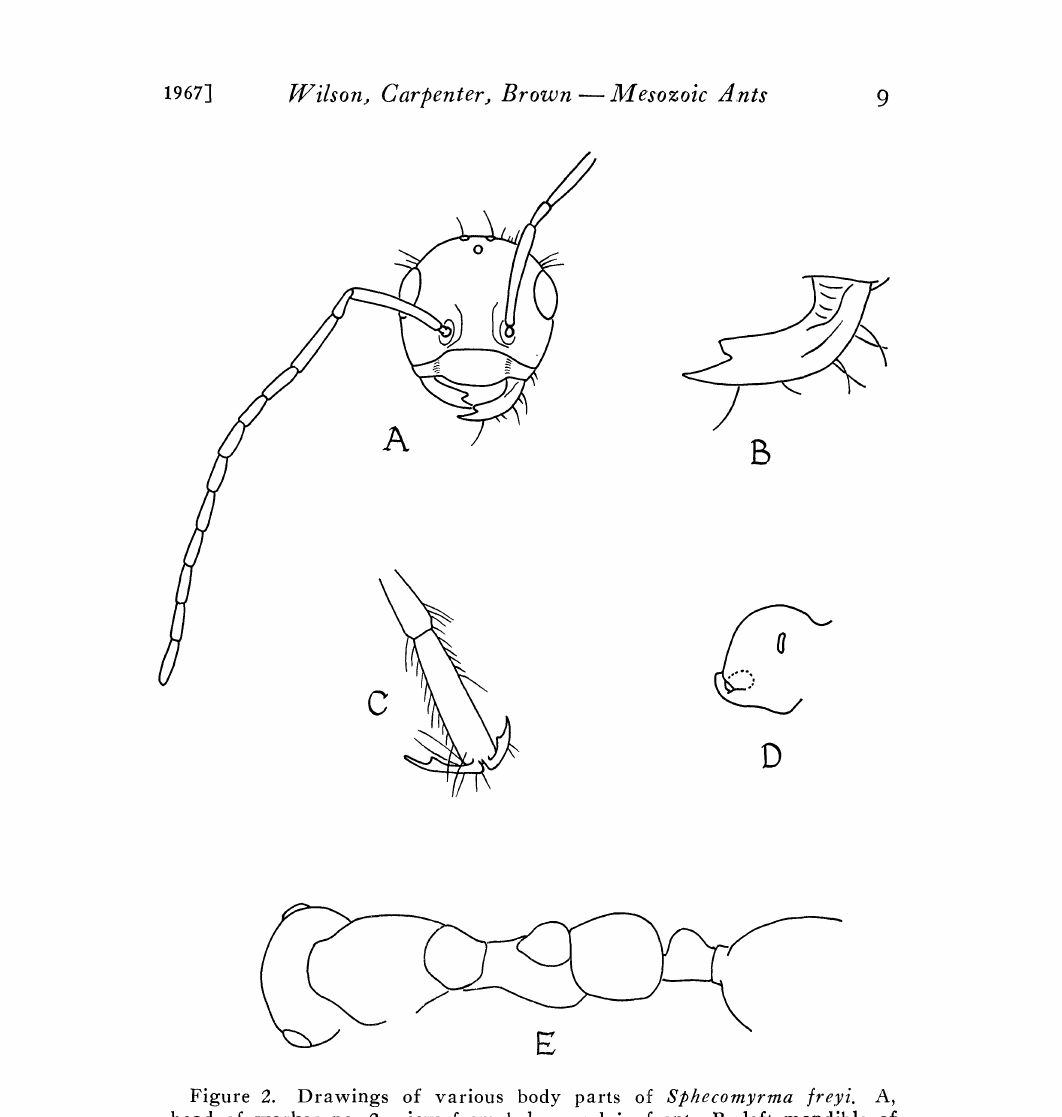
Figure 2. Drawings of various body parts of Sphecomyrma freyi. _A, head of worker no. 2, view from below and in front. B, left mandible of worker no. 2, seen in fuller frontal view than in A so as to reveal the truncated shape of the inner tooth. C, pretarsus of left hind leg of worker no. 1. D, propodeum and metapleural region of worker no. 1. E, oblique dorsal view of body of worker no.